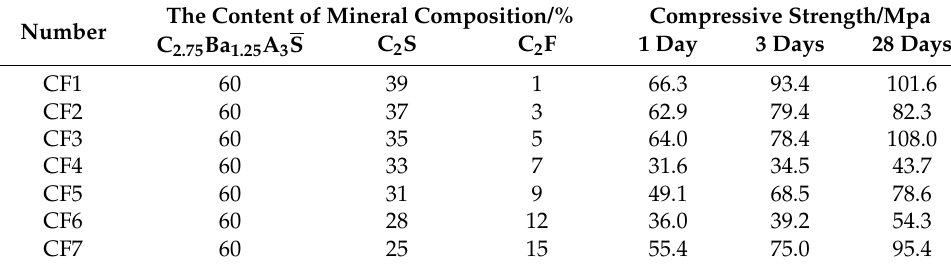
Table 3. Compressive strength of clinker at 1350 ◦ C.